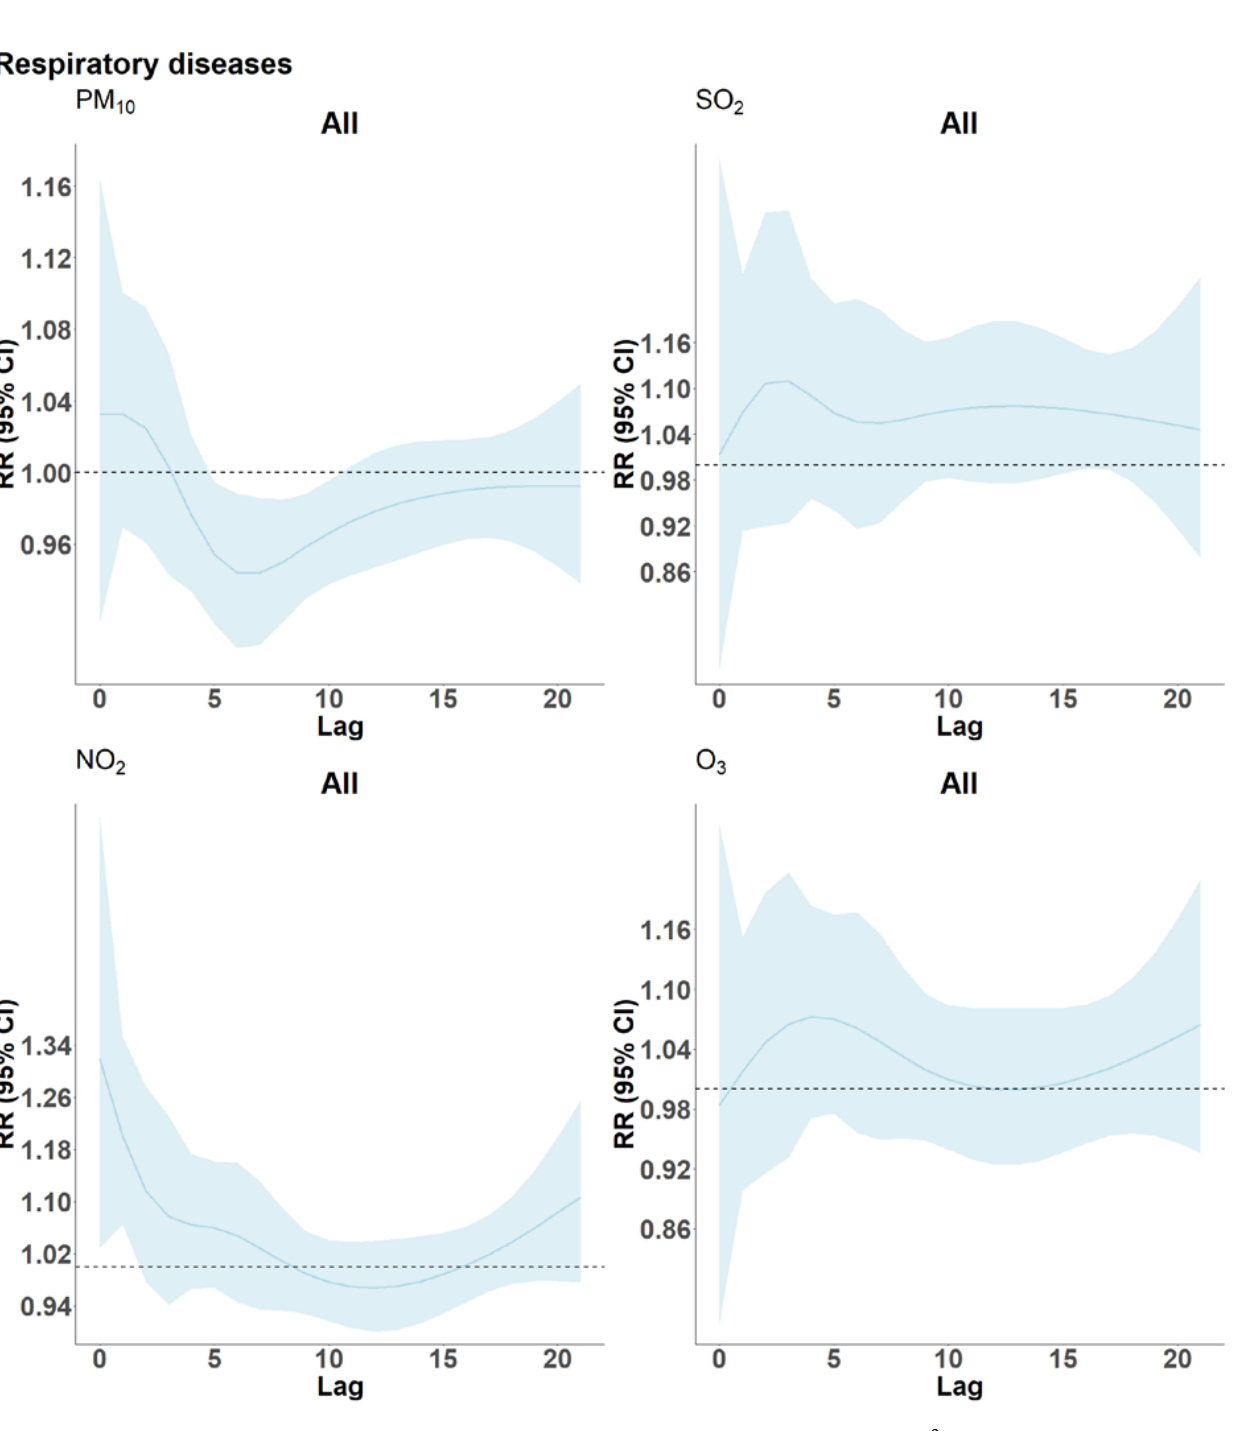
Figure 5. Lag structure (0–21) of the estimated effects of a 10 µg/m 3 increase in PM10, NO2, SO2 and O3 concentrations on respiratory disease mortality in Cape Town, South Africa, 2006–2015. The blue curve gives the RR-estimates and the light blue band their 95%-confidence intervals.